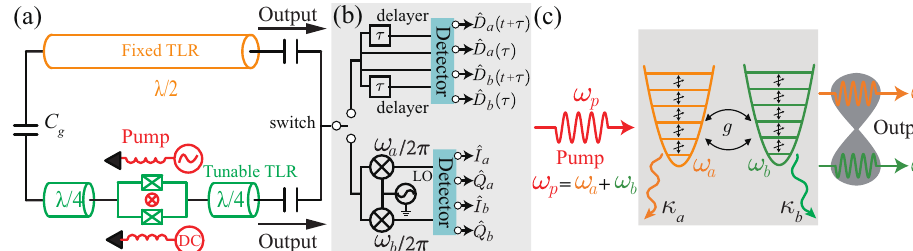
Figure 1. ( a ) Equivalent circuit of our proposed scheme to emit entangled frequency-tunable mi- crowave photons. A λ /2 frequency-fixed TLR (orange) coupled to a λ /2 frequency-tunable TLR (green) via a coupling capacitor C g . The tunable resonator is inserted with a SQUID that is composed of two identical Josephson junctions. The SQUID is driven by an external direct current (dc) flux bias Φ dc and a continuous microwave tone (ac) Φ ac . The output signals are processed by a detector. ( b ) (Upper panel) A proposed sketch of a setup for detecting the correlations of output photons. The second-order coherence function can be calculated by recording the intensities of modes such as ˆ D ˆ D ˆ D ( t ) , and ˆ D ( t + τ ) . (Lower panel) A proposed schematic to observe the in-phase a ( t ) , a ( t + τ ) , b b and quadrature voltages of output signals from the circuit. The emitted microwave signals are de- modulated via a local oscillator (LO) and into the detector for calculating the quadrature components, which can be used to reconstruct the quantum properties of output signals using ˆ I a , ˆ Q a , ˆ I b , and ˆ Q b for modes a and b . ( c ) Model of generating the entangled microwave photons. The green and orange energy levels represent the harmonic behavior of modes a and b . κ a and κ b are the rates of decay into the environment of the two modes a and b , respectively. The curves with double arrows indicate the coupling between two oscillators. The red microwave signal denotes the extra pump field. The dark gray oval is the output envelope consisting of the entangled modes a and b